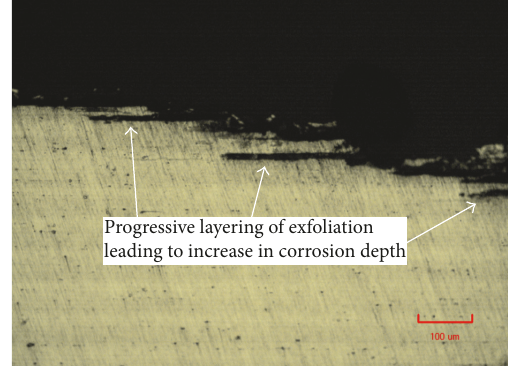
Figure 4: Unclad panel deep exfoliation damage, 100x magnifica- tion and 10-micron